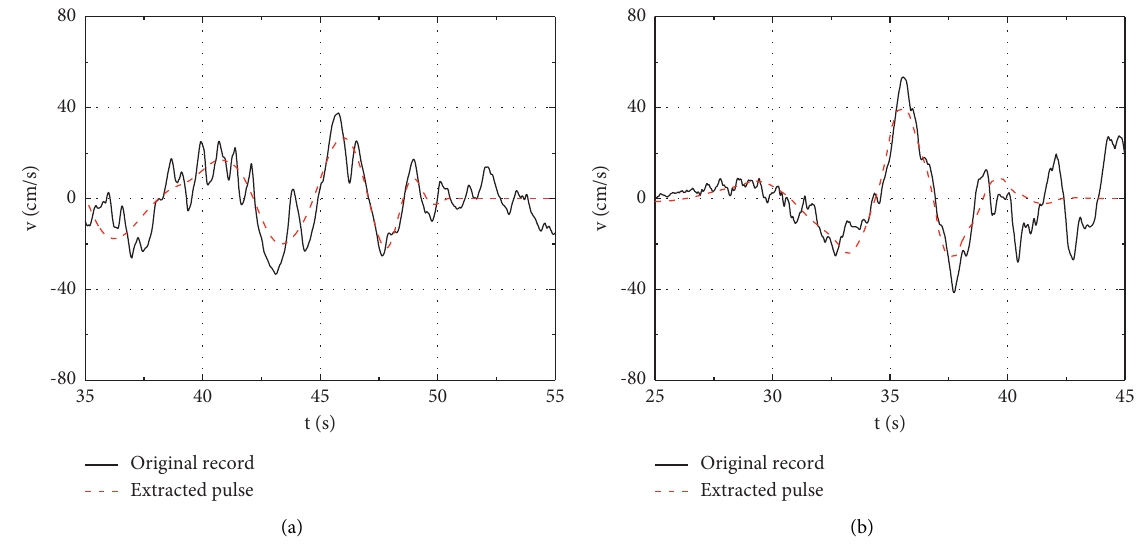
Figure 18: No. 1194 ground motion. (a) The extracted pulse based on HHT. (b) The extracted pulse based on